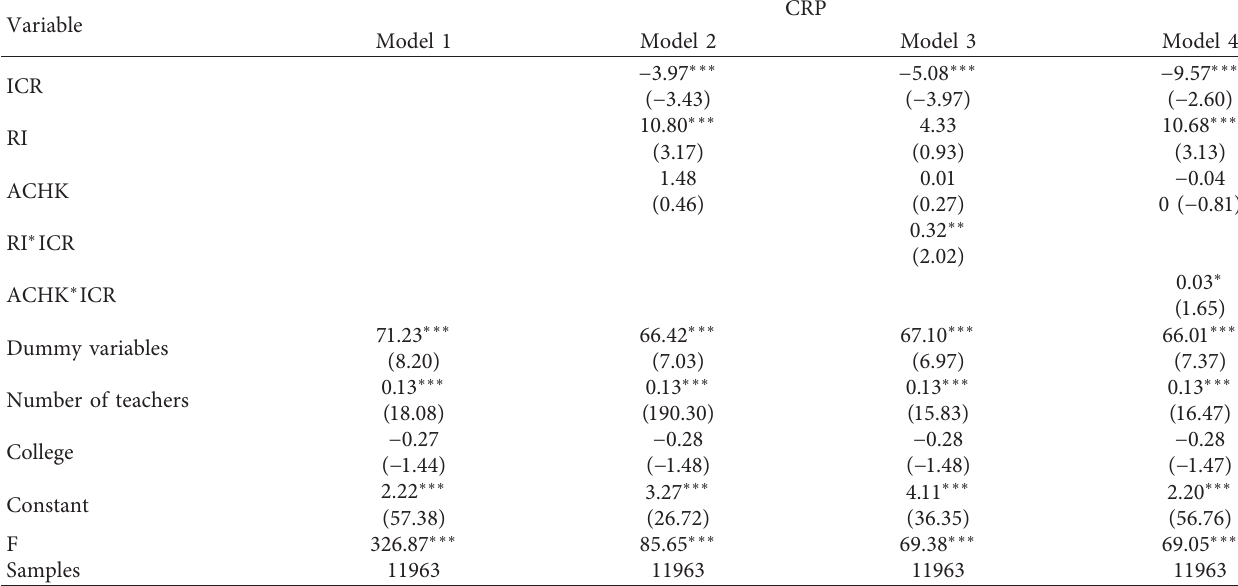
Table 2: Results of regression analysis.